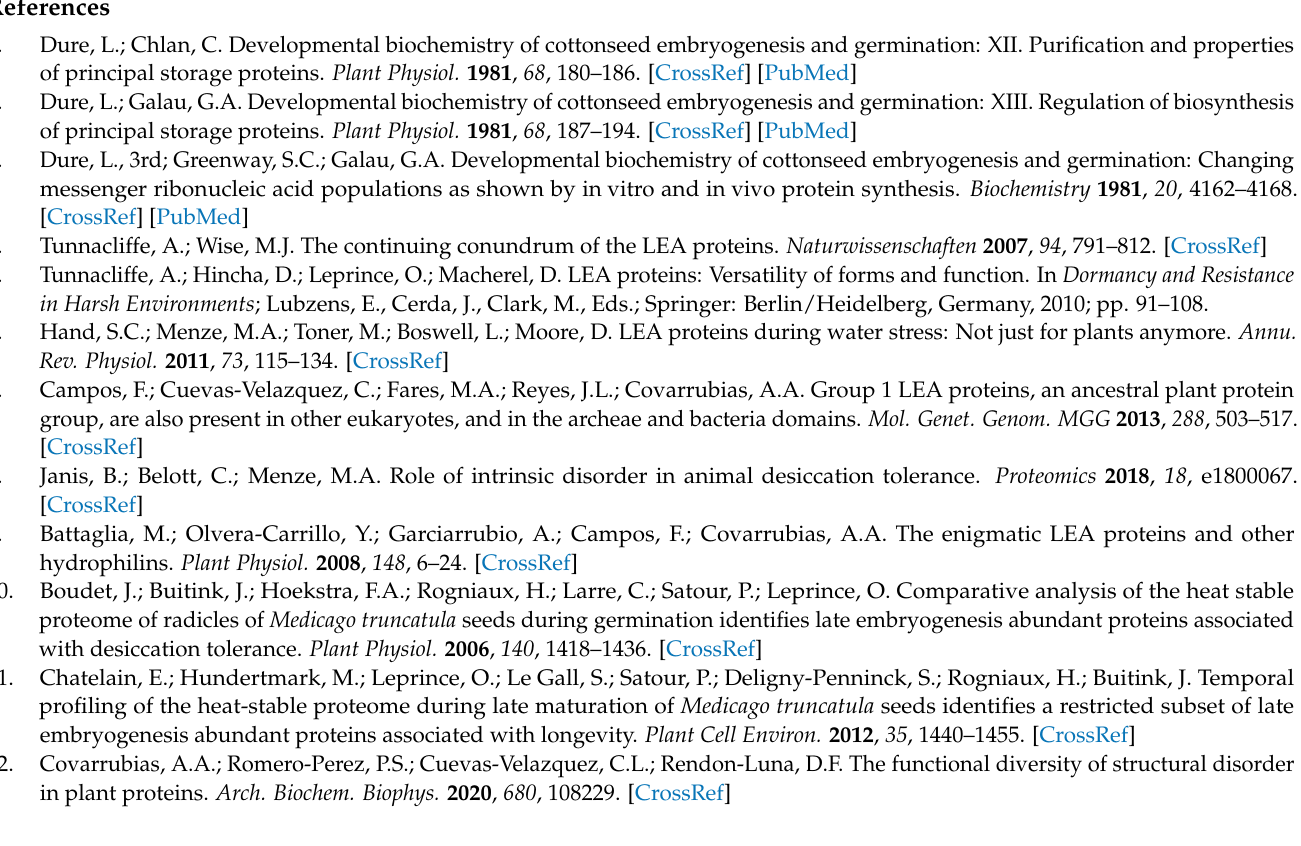
Figure S4: Localization of seed-expressed LEA_4 proteins different organs of 4-d-old seedling under control condition. If the organ is only shown with a bright field image, no fluorescence signal of Venus was detected. Red channel shows chlorophyll signal. White and black bars indicate 100 µ m while blue bars indicate 10 µ m. Supplementary Table S1: AGRIS promoter motif analysis. (A) Frequency of promoter motifs in each LEA proteins. AGRIS AtcisDB database was used for the motif identification. (B) Common promoter motifs among LEA proteins sharing the same subcel- lular localization. Supplementary Table S2: Length of native promoters and number of introns in LEA_4 group genes used for subcellular localization studies. Supplementary Table S3: Primer list. Supplementary Table S4: Localization prediction results of 11 seed-expressed LEA_4 proteins. The prediction showed either the subcellular structure(s) with the highest score of predictions or the results of the prediction with no scores. Empty spaces illustrate no prediction by that particular tool. CW—Cell Wall, ER—Endoplasmic Reticulum. Supplementary Table S5: Predicted Eucaryotic Linear Motifs (ELM) in LEA9 sequence. Supplementary Video S1: Division and fusion of cytoplasmic condensates of embryos of dry seeds from proLEA9::LEA9:Venus